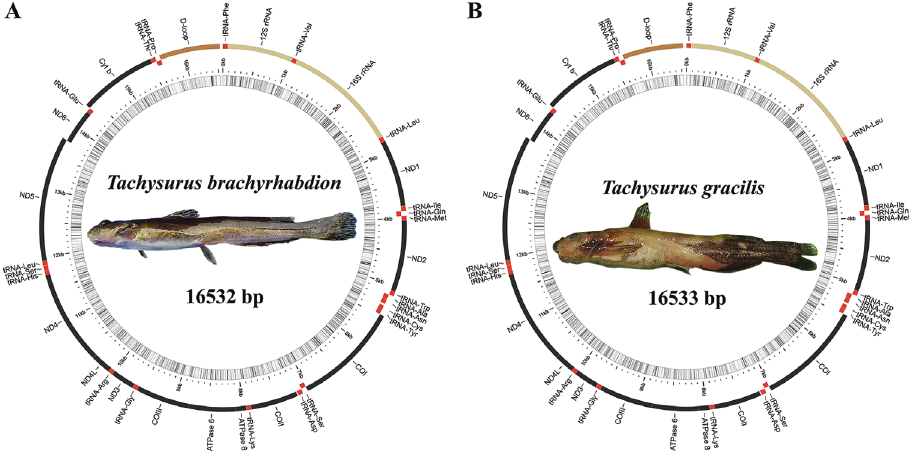
Figure 1. Circular map of the two catfishes mitochondrial